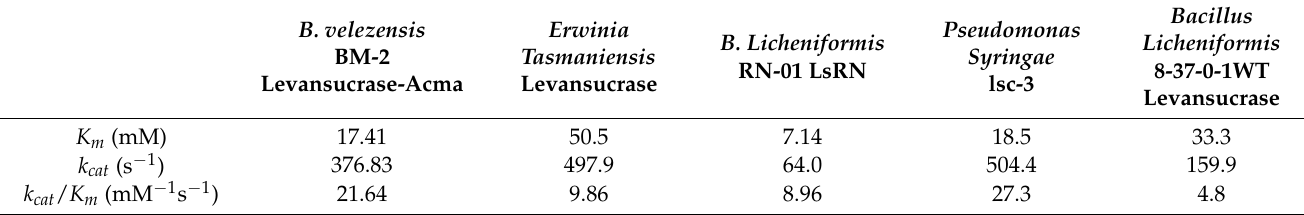
Table 1. Kinetic parameters of levansucrase in comparison with other